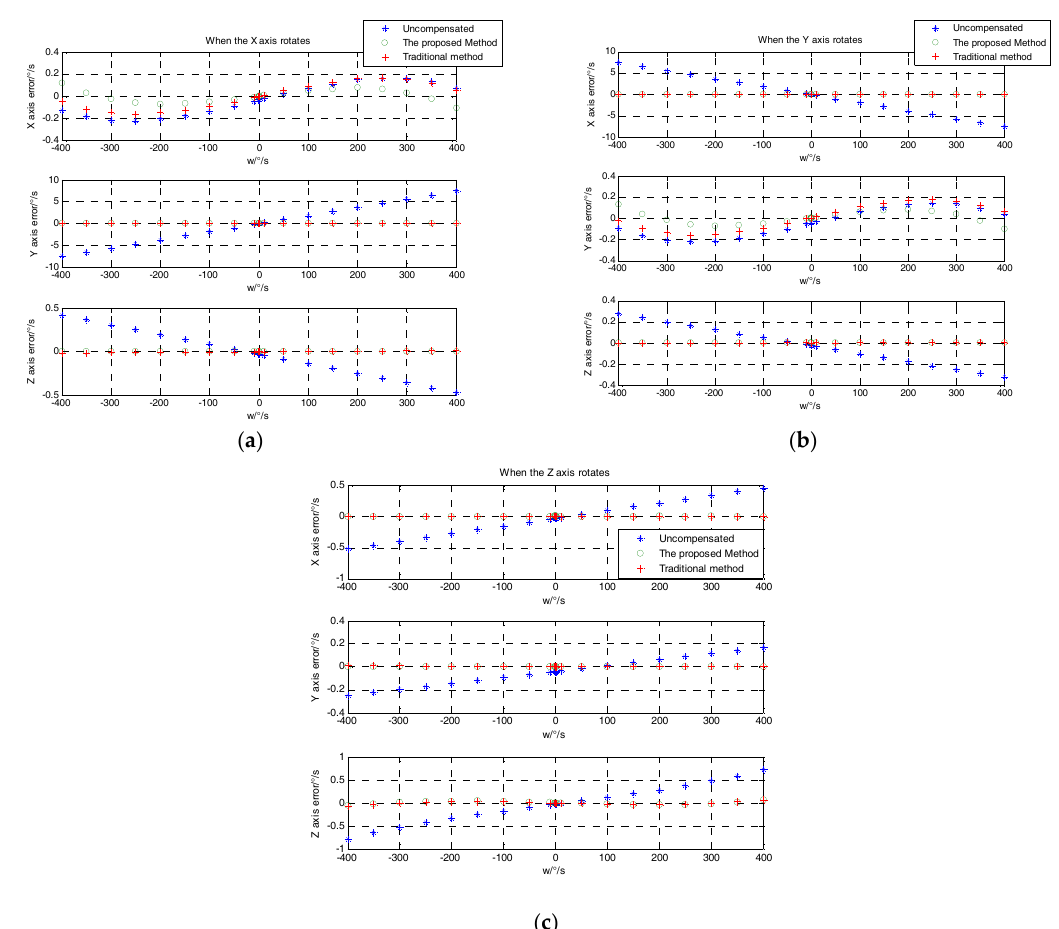
Figure 8. Error distribution of each axis (determined using the uncompensated, proposed, and traditional methods). ( a ) Error distribution when the X-axis rotates; ( b ) error distribution when the Y-axis rotates; ( c ) error distribution when the Z-axis rotates.